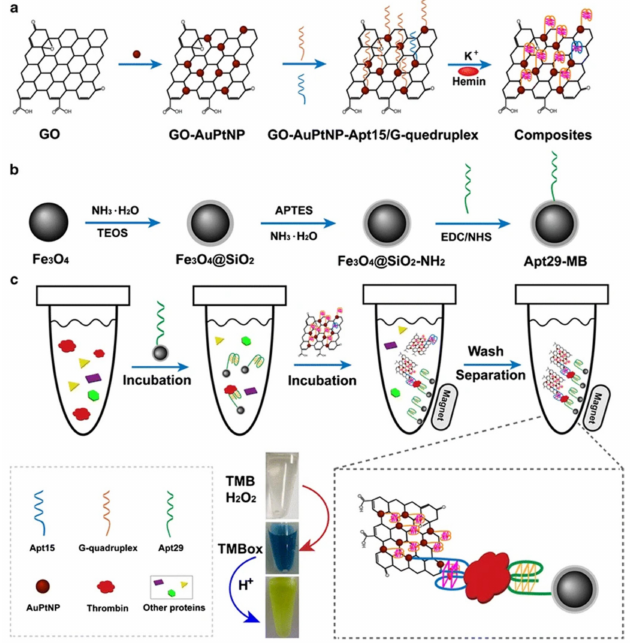
Figure 3. Schematic illustration of assembly processes of TBA1 modified composite with peroxidase- mimetic activity and TBA2 functionalized magnetic bead and procedure of colorimetric detection of thrombin. Adapted with permission from Ref. [72]. Copyright (2017), Springer